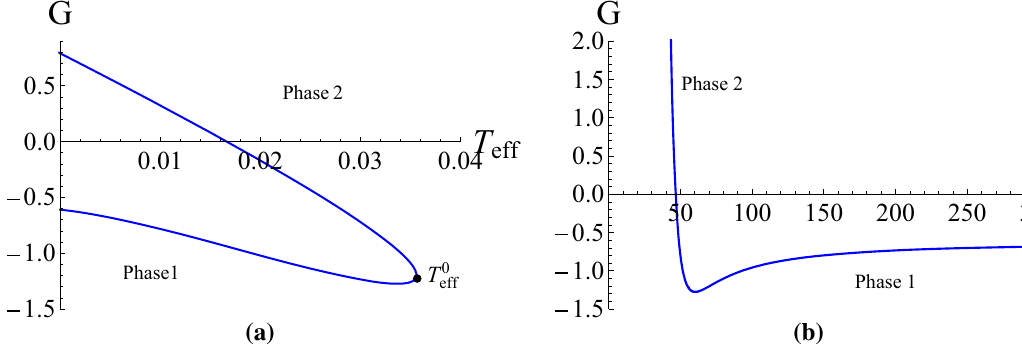
Fig. 10 The same as Fig. 9, but for the behavior of the Gibbs function